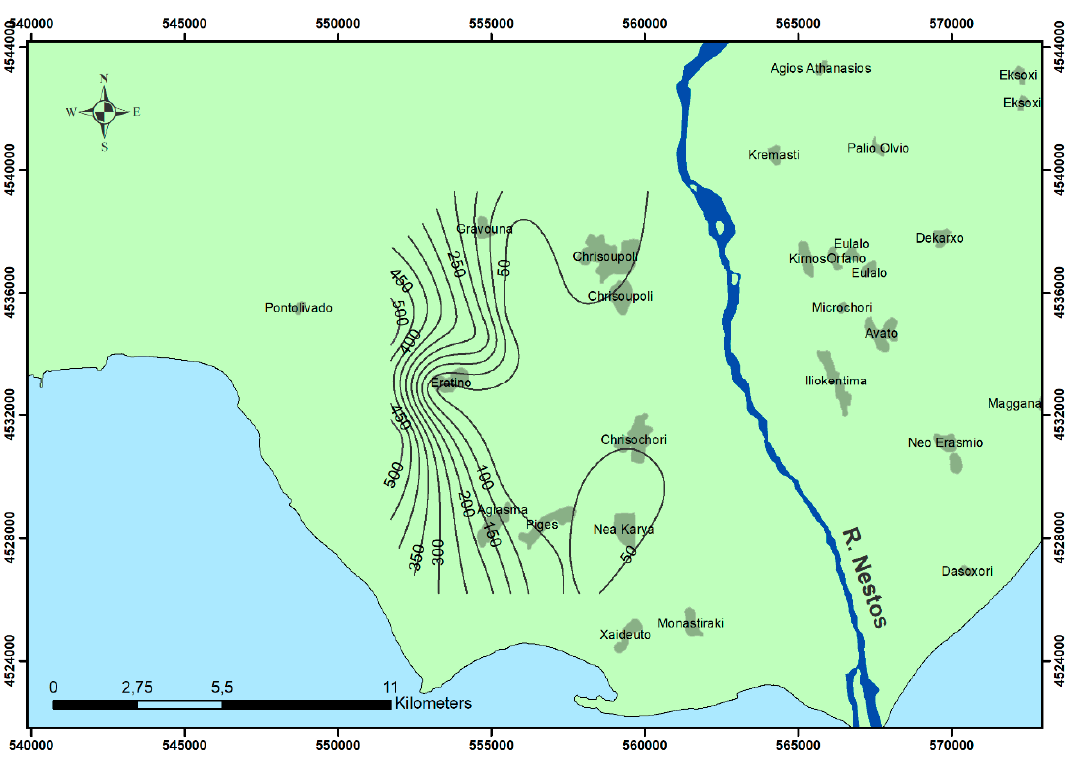
Figure 13. Chloride ion (Cl − ) distribution map (mg/L) of the unconfined aquifer (May 2019).